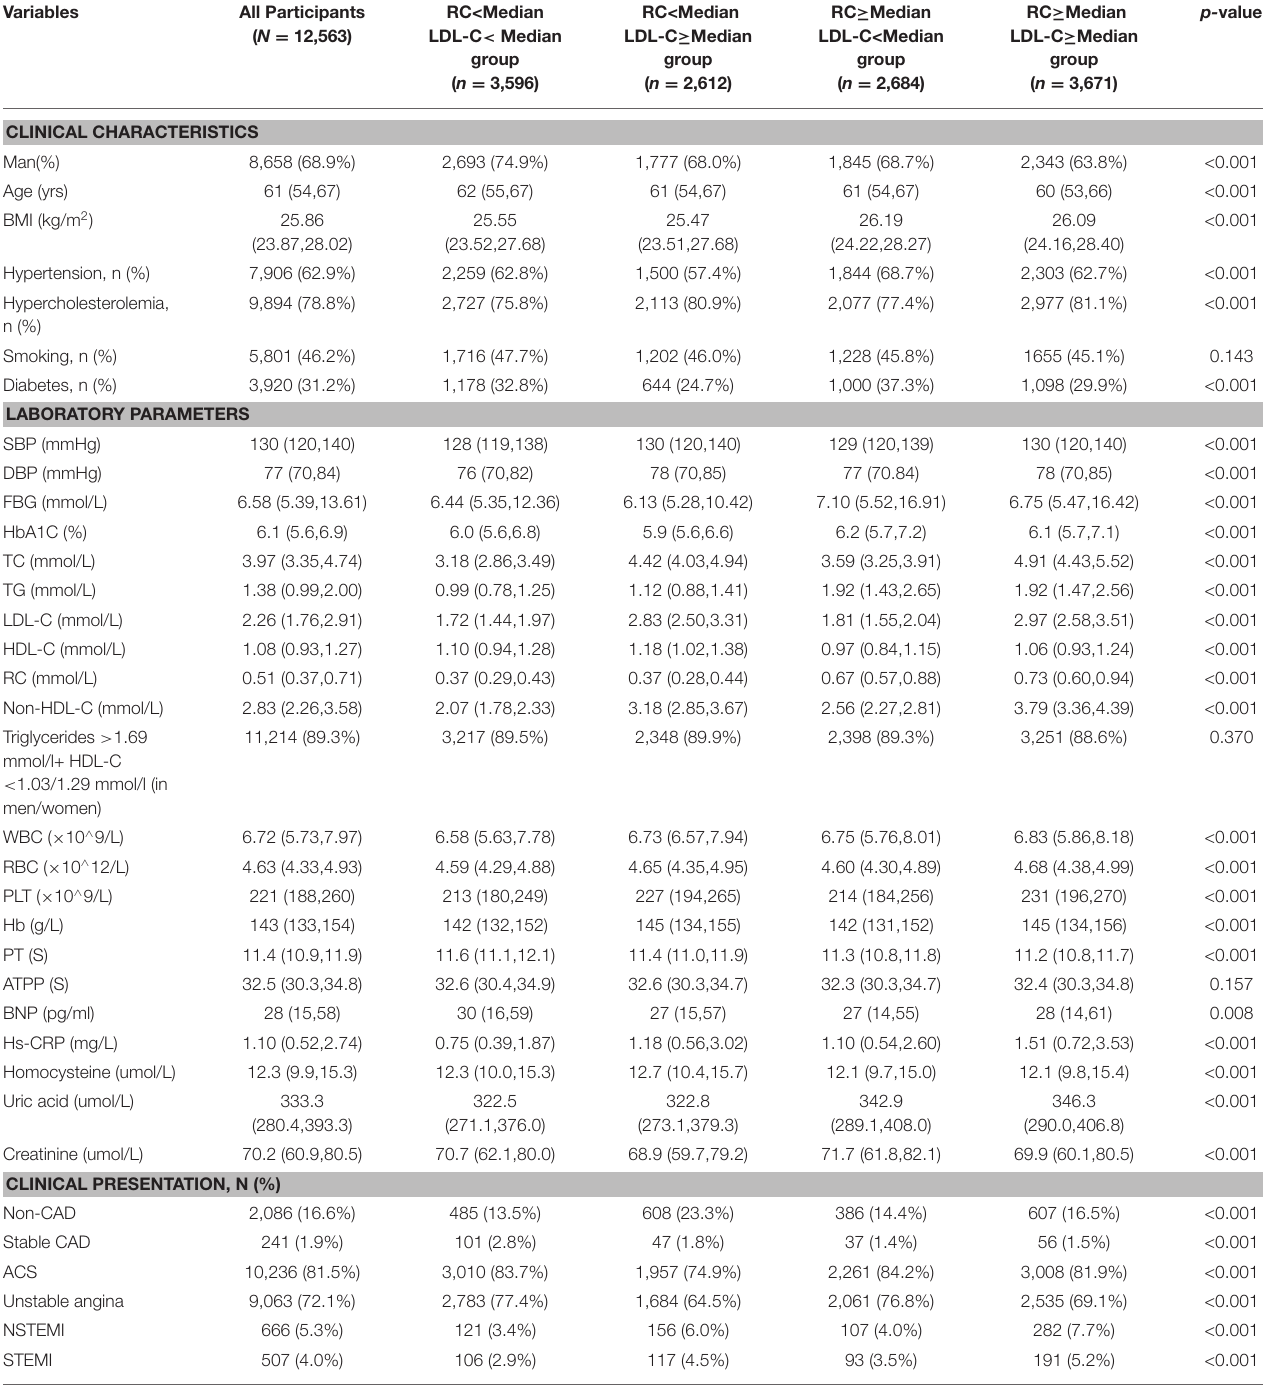
TABLE 1 | The baseline clinical characteristics and laboratory parameters of the patients according to the remnant cholesterol (RC) and the low-density lipoprotein cholesterol (LDL-C) index categories.